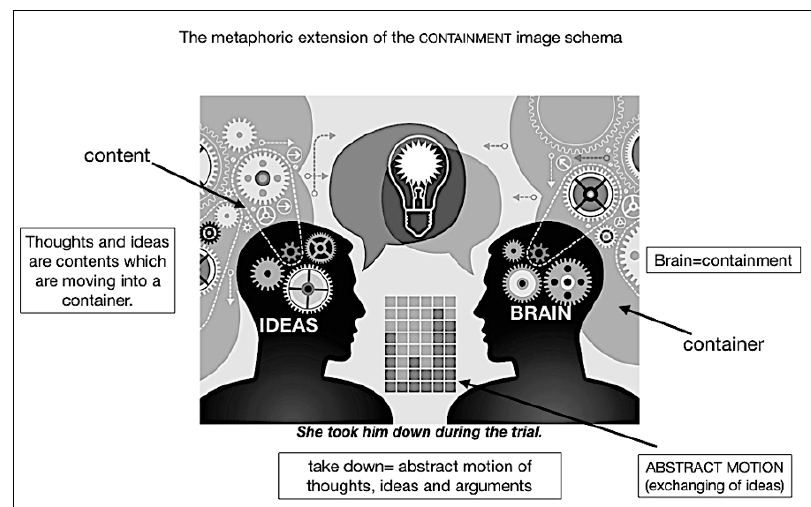
Figure 2 . The CONTAINMENT image schema: the case of take down.